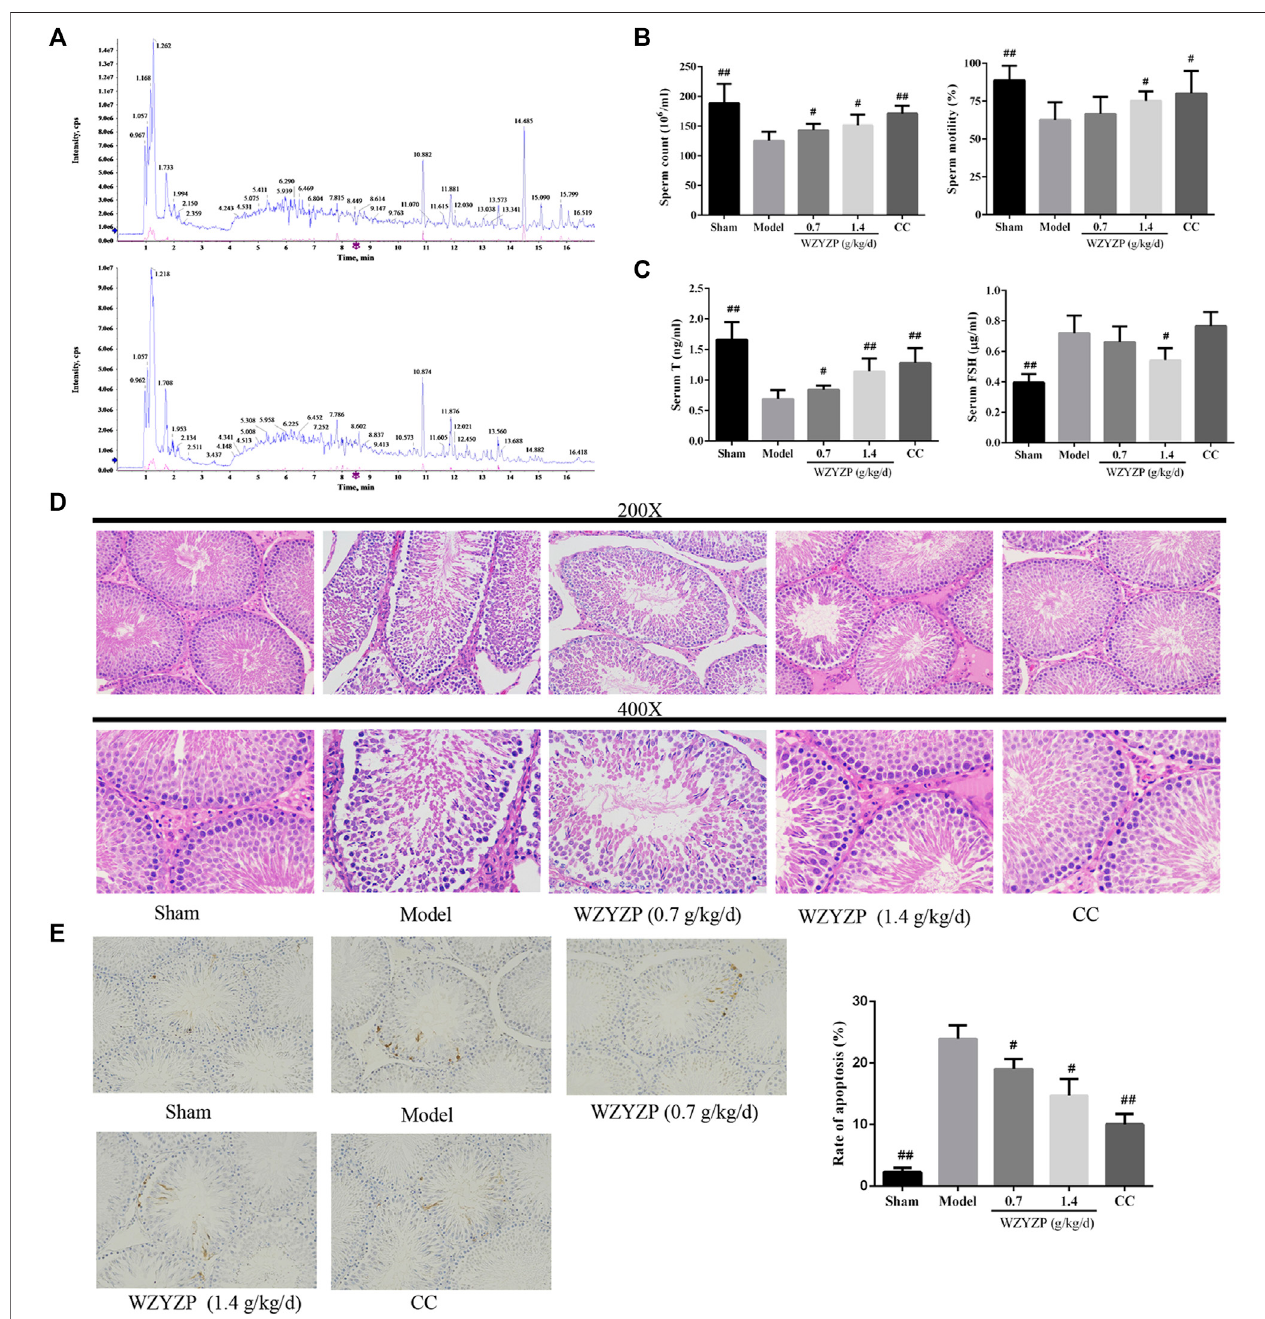
FIGURE 4 | Compounds identi fi cation and the effect of the WZYZP on the experimental spermatogenesis disorder model rats. (A) The phytochemical compositions identi fi cation in theWZYZPbyUHPLC-Q-TOF/MS in thepositive ionmode and negative ion mode. (B) EffectoftheWZYZPon sperm counts and motility. (C) Effect of WZYZP on serum hormone levels of T, FSH levels were detected with an ELISA assay. (D) HE staining to evaluate the effect of the WZYZP on rat testes histologicalchanges.Above,magni fi cation × 200,400. (E) TUNELstainingfortheevaluationofcellapoptosis.Above,magni fi cation × 200. # p < .05vs.Modelgroup, ## p < .01 vs. Model